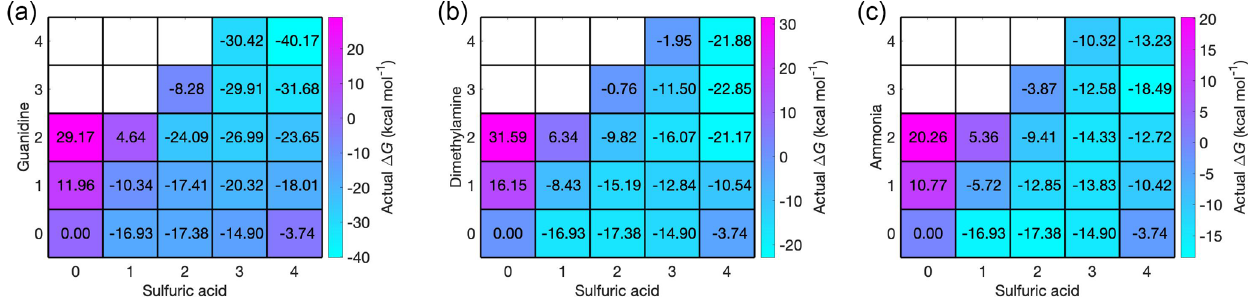
Figure 6. Concentration-dependent Gibbs free energies for bisulfate-containing acid–base clusters at 298.15K. Sulfuric acid concentration is 10 7 cm − 3 in all cases, and for bases the relative concentrations of [guanidine] = 10 − 5 ppt V (a) , [dimethylamine] = 1ppt V (b) and [am- monia] = 10 5 ppt V (c) are used. Note that the x and y axes refer to the numbers of neutral acid and base molecules and each cluster contains one bisulfate anion.